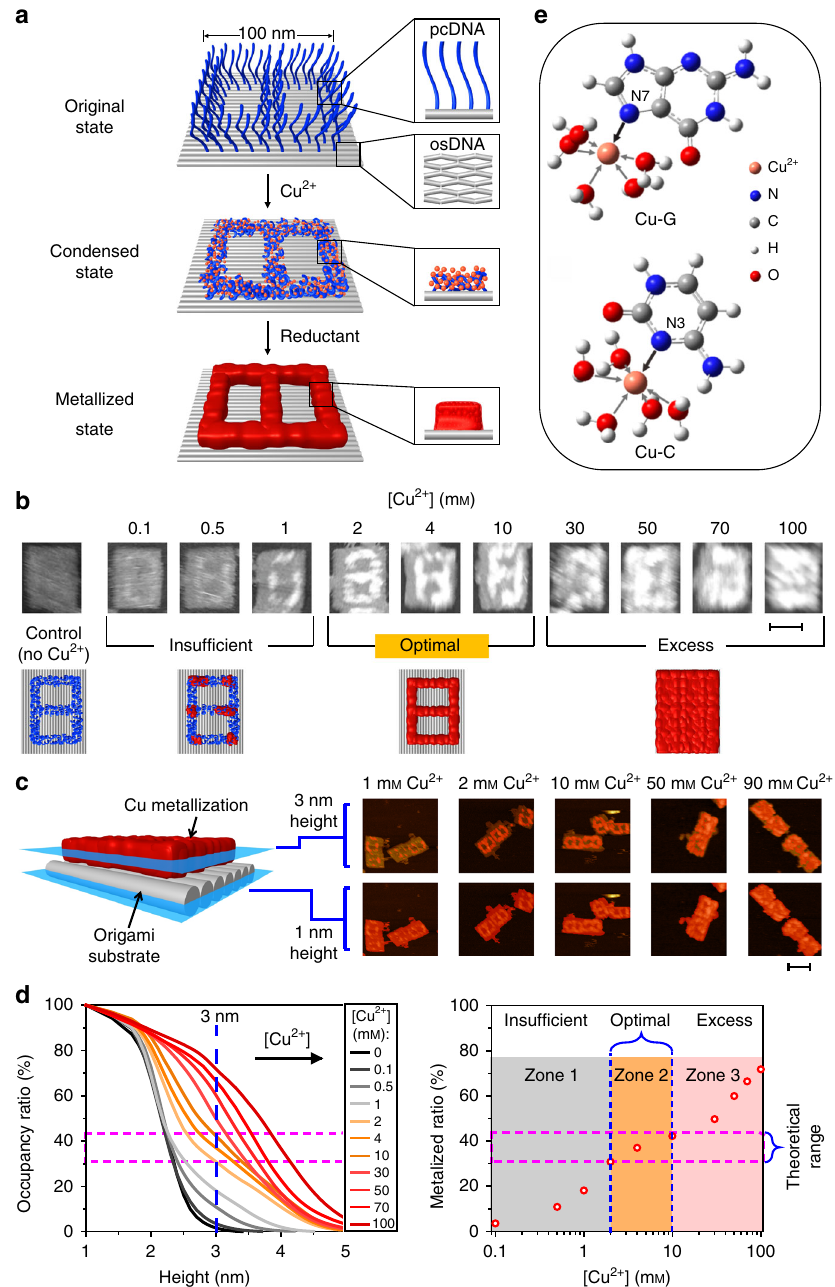
Fig. 1 Selective on-origami DNA condensation and metallization. a Illustration of condensation and subsequent site-speci fi c metal plating processes for fabricating a digit 8 pattern on a single-origami breadboard with a size of 100 × 70 nm 2 . b AFM images of metalized digit 8 patterns constructed with different Cu 2 + concentrations. Scale bar: 50 nm. c Tomographic measurements of cross-sectional areas. Tomography images (showing red masks on original AFM images) of origami substrates (cross-sections at 1 nm height) and metallized areas (cross-sections at 3 nm height) from typical samples. Scale bar: 100 nm. d Normalized occupancy ratios of the areas on origami at different heights of cross-sections obtained from tomography analysis (left) of the patterns showing in ( b ). The size of the origami substrate (measured from the cross-sectional area at 1 nm — half the original origami height) is represented with 100%. Metallized area proportions with different Cu 2 + concentrations obtained from the normalized occupancy data at 3 nm height (1 nm above from the origami substrate) (right). e Geometry-minimized structure of Cu-G and Cu-C complexes obtained from quantum mechanical